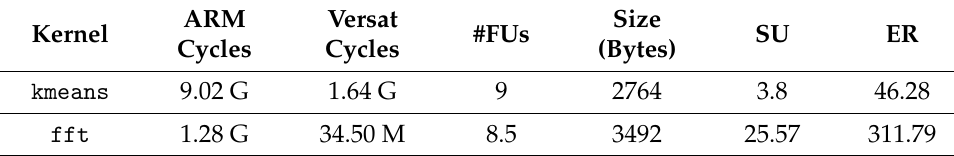
Table 7. Complex kernel